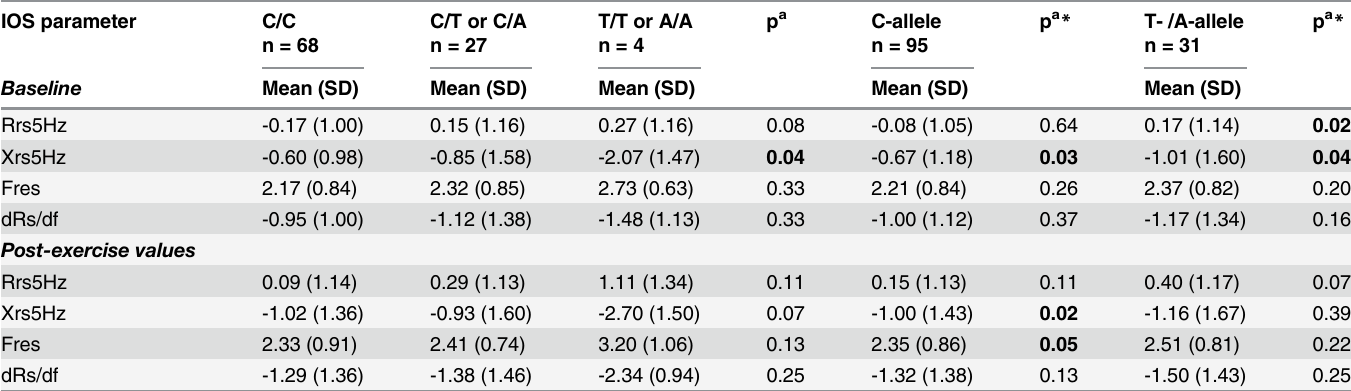
Table 3. Impulse oscillometry presented as Z-scores in relation to IL-10 rs1800871/rs1800872 polymorphisms in 99 children under the age of seven after hospitalisation for bronchiolitis at less than six months of age.